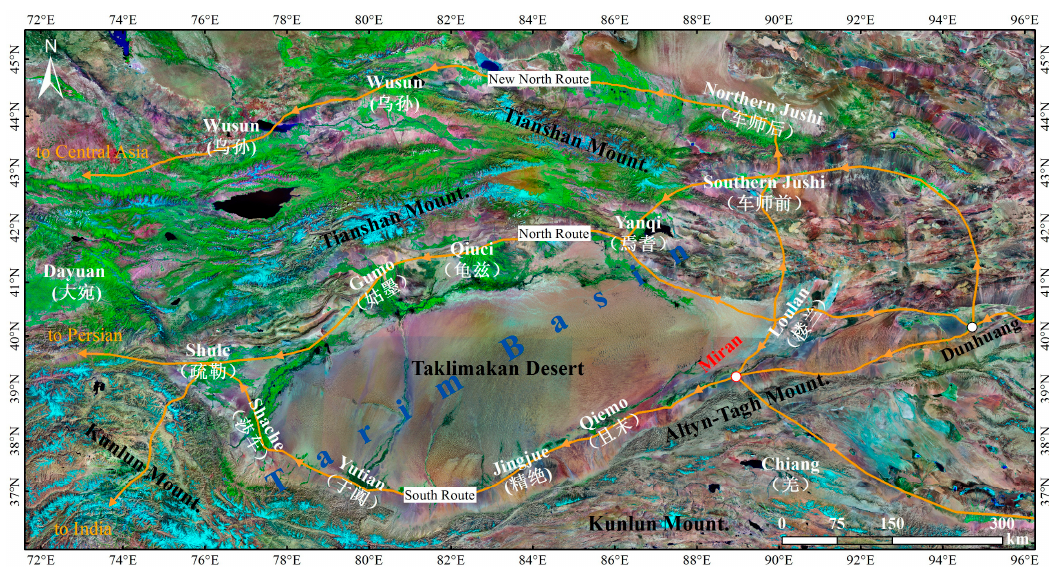
Figure 1. Map of ancient Miran and the main Silk Road routes in the Western Regions Section where the orange lines represent the Silk Road routes, and the white words indicate the general locations of the major oasis Kingdoms during the Early Han Dynasty. The base map is Landsat TM imagery, which can be downloaded from http://maps.ngdc.noaa.gov/.